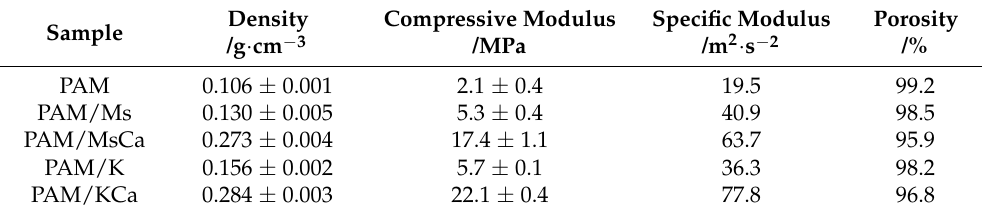
Table 1. The physical and mechanical properties of different PAM composite